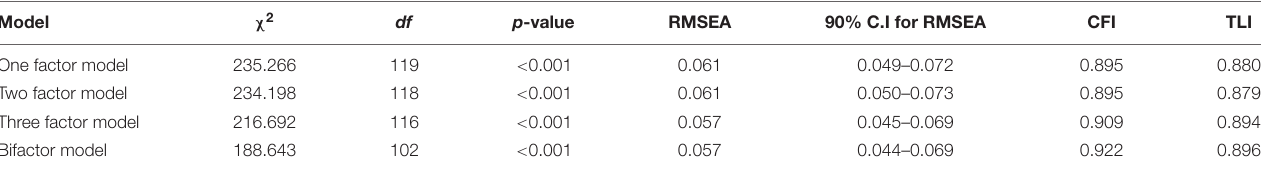
TABLE 1 | Comparisons of Model fit for the ACIPS scale.